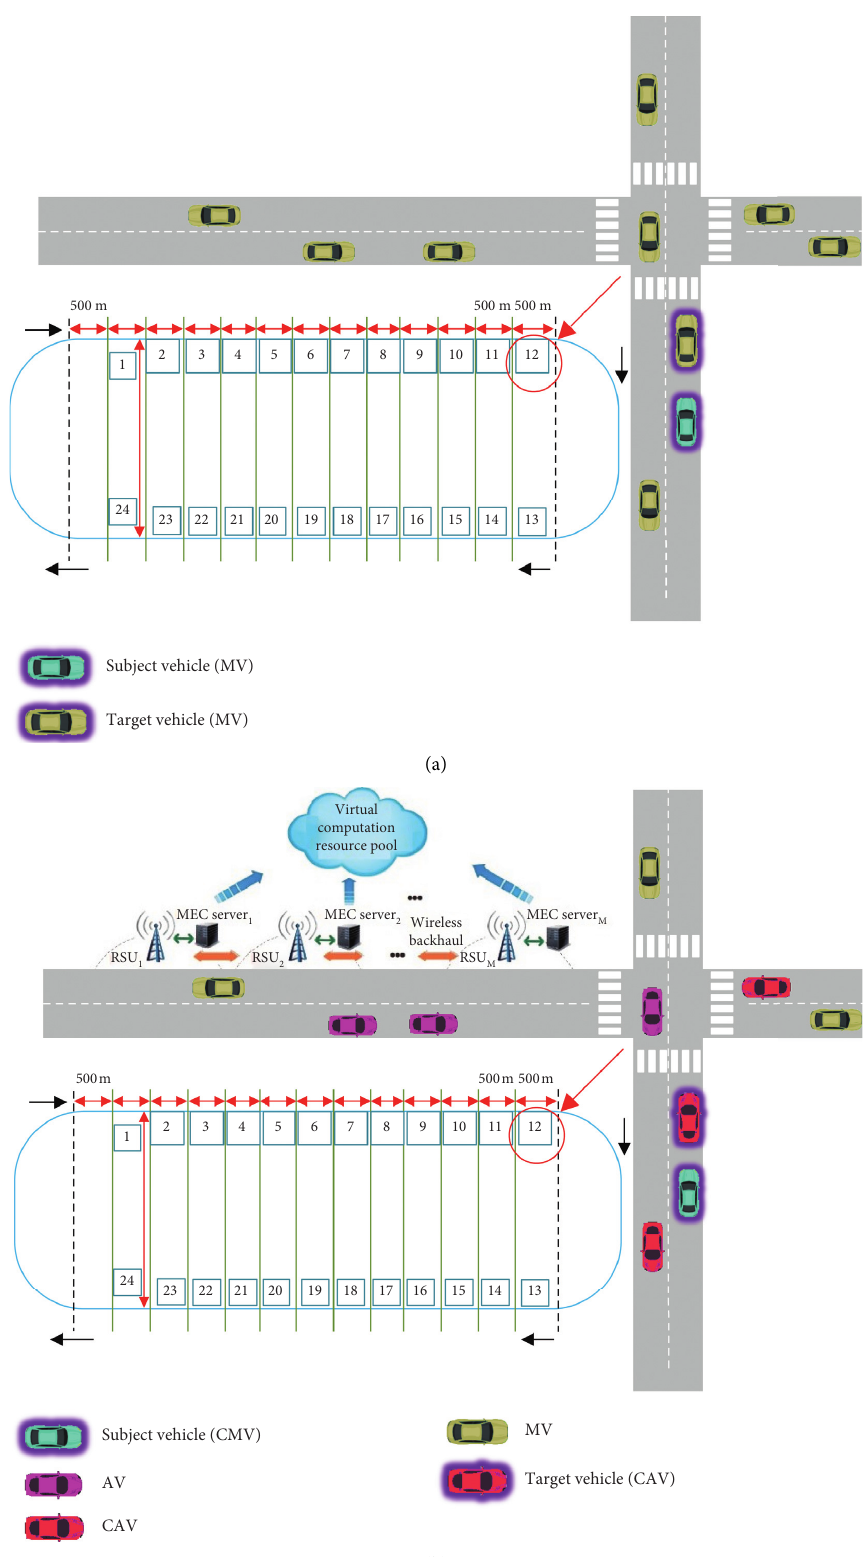
Figure 4: (a) Traditional traffic environment. (b) Mixed traffic